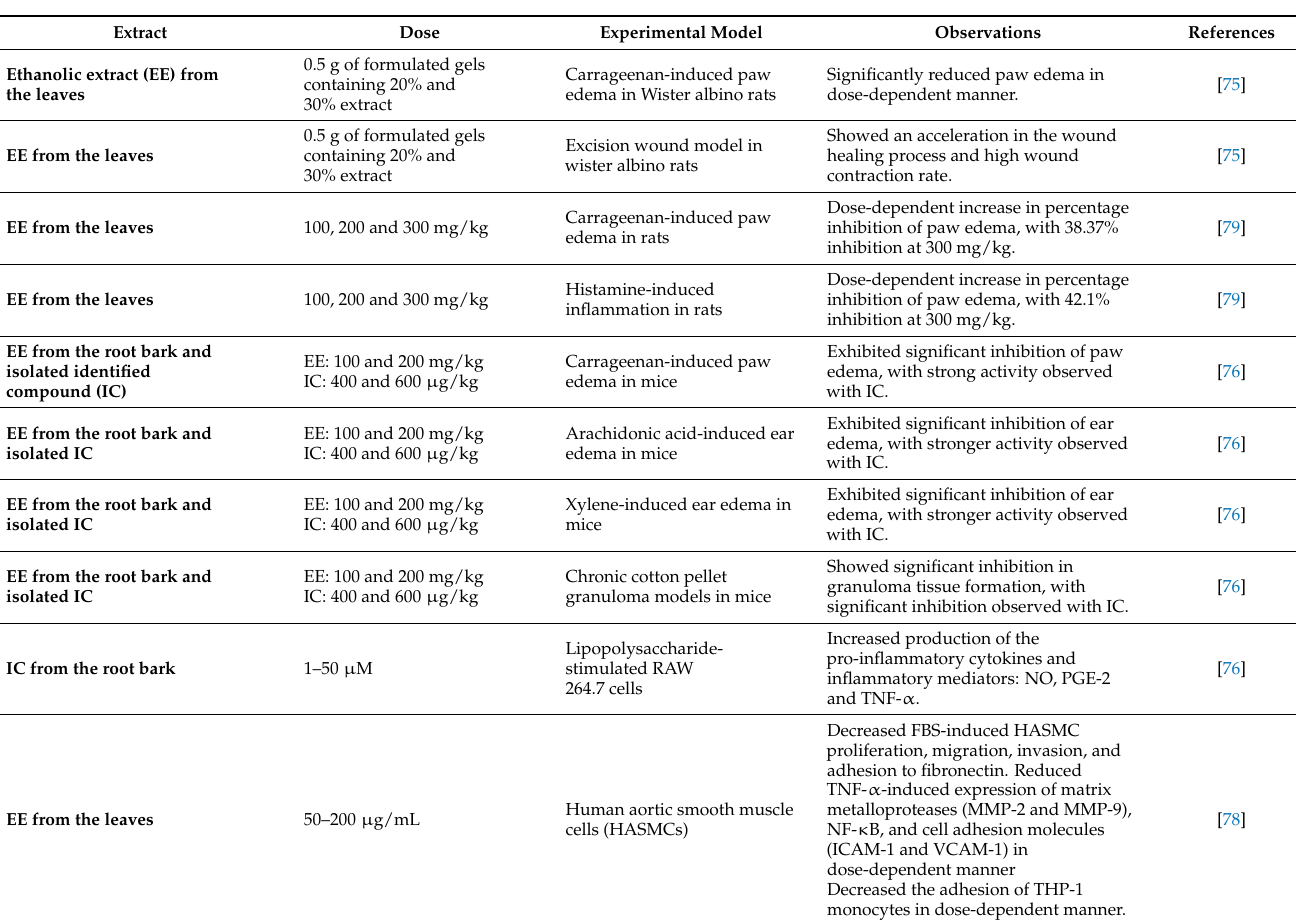
Table 6. The anti-inflammatory effects of Ziziphus nummularia